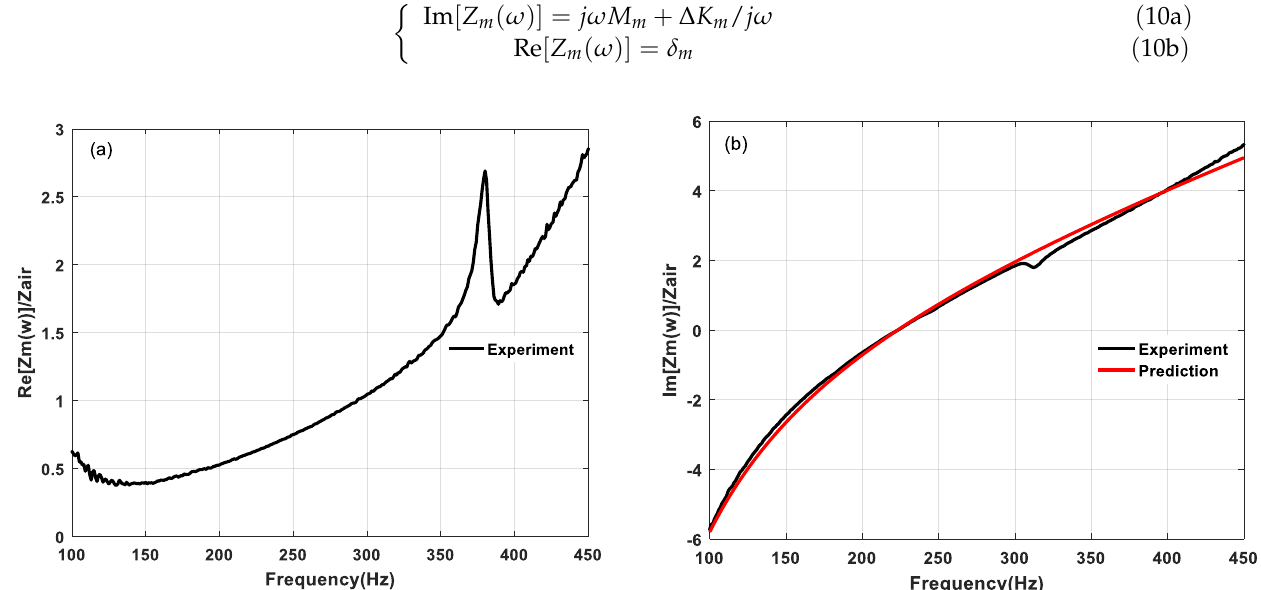
Figure 6. Experimental impedance of the open circuit: ( a ) the specific acoustic resistance; ( b ) the specific acoustic reactance.